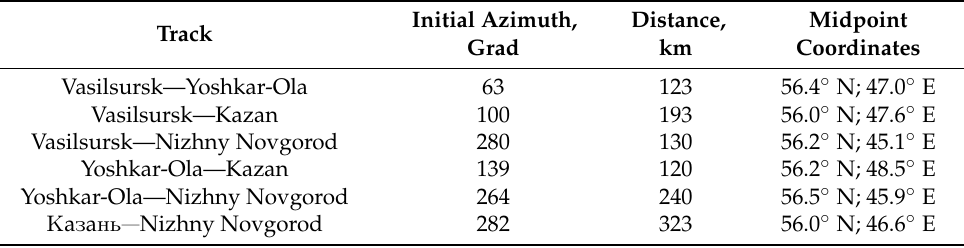
Table 2. Sounding paths